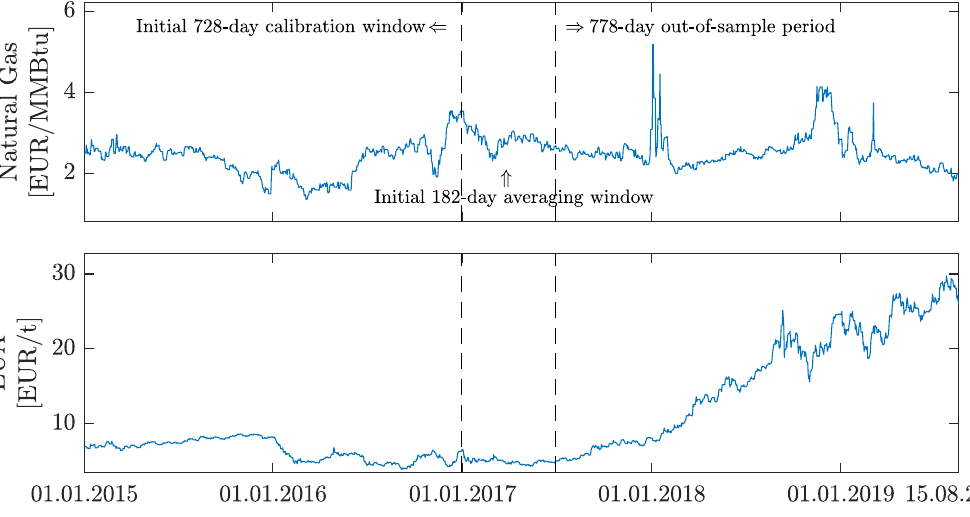
Figure 3. Daily natural gas spot prices ( top ) and carbon emission allowances (EUA) spot prices ( bottom ). Data span from 1 January 2015 to 15 August 2019. Note that for each series plot, the limits on the y axes are differ. The first vertical dashed line marks the end of the 728-day calibration period and the second marks the end of the initial 182-day calibration window for averaging